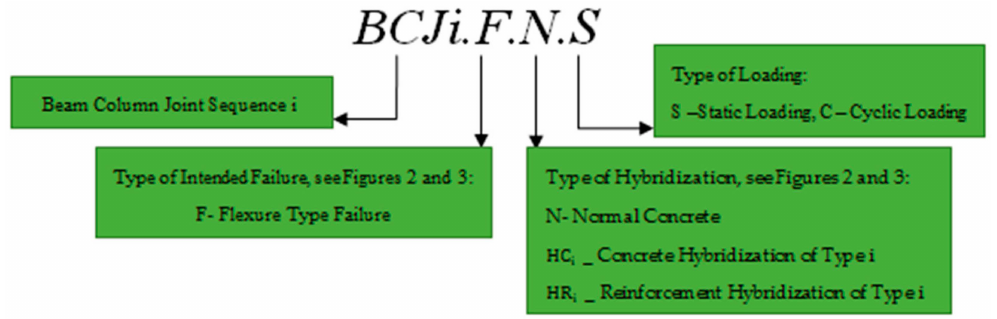
Figure 1. Designation of tested beam-column joints. Table 1. Details of tested beam-column joints.